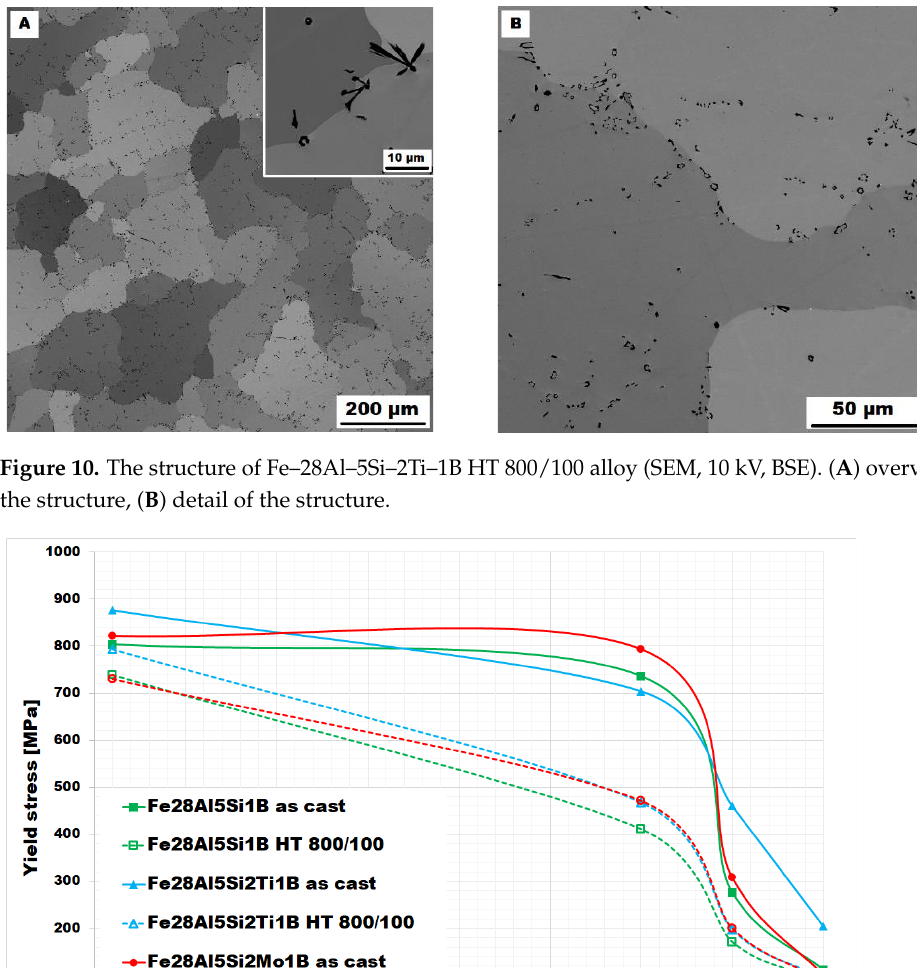
Figure 10. The structure of Fe – 28Al – 5Si – 2Ti – 1B HT 800/100 alloy (SEM, 10 kV, BSE) . ( A) overview of the structure, ( B ) detail of the structure